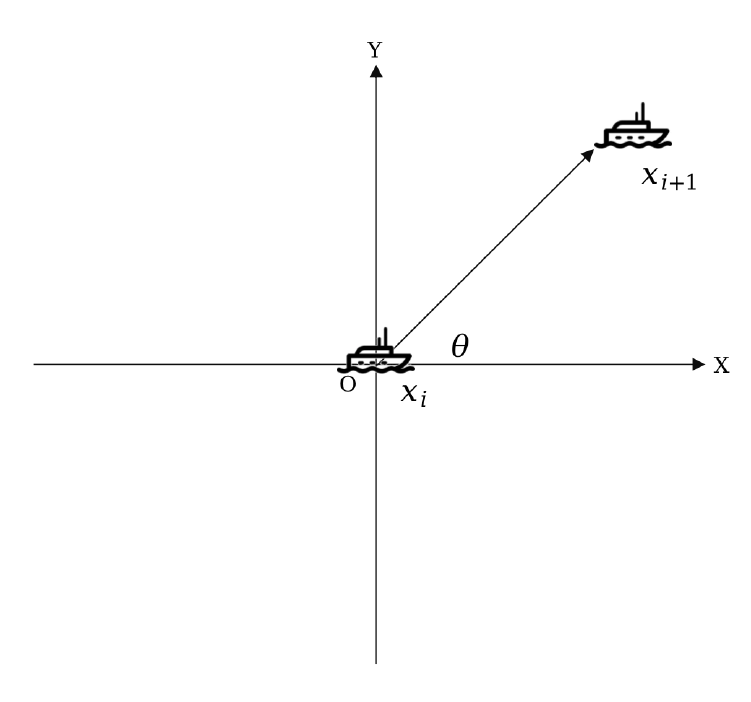
Figure 1. A USV motion coordinate